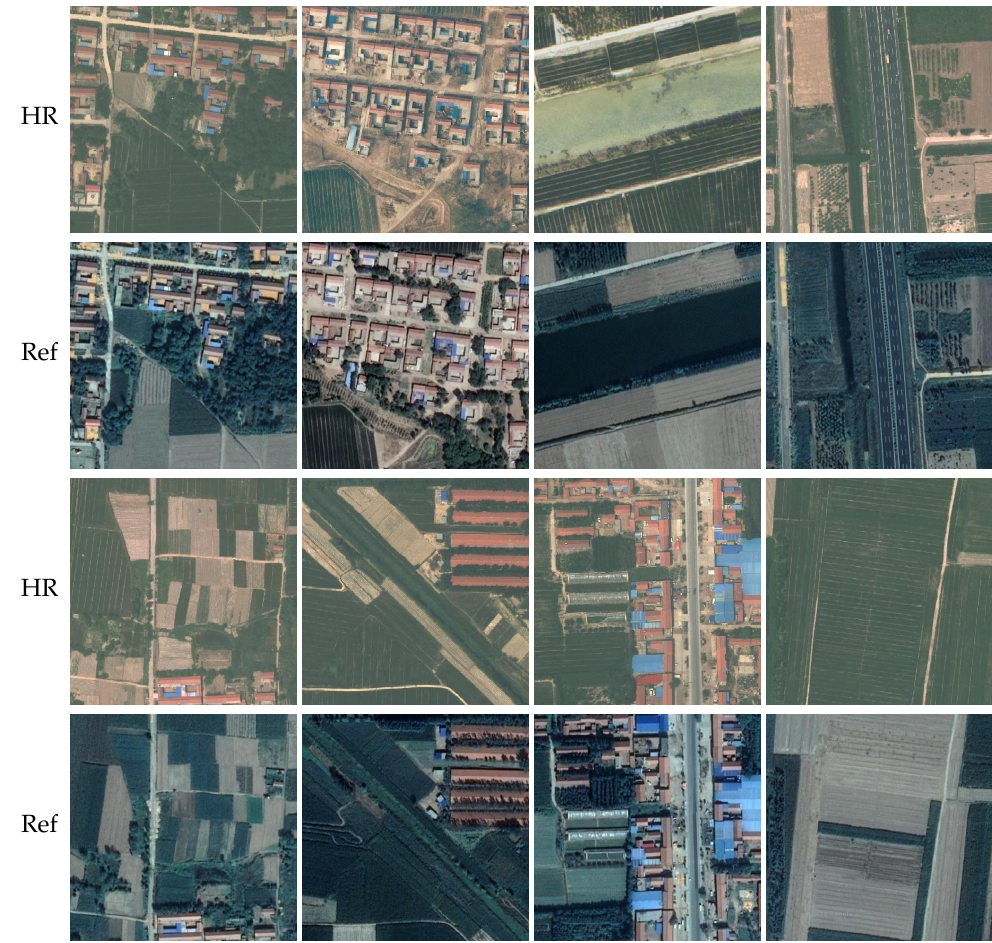
Figure 4. Examples of RRSSRD training set. The first and third rows represent HR images while the second and fourth rows represent Ref images. Specifically, HR images in the first row correspond to Ref images in the second row, and HR images in the third row correspond to Ref images in the fourth